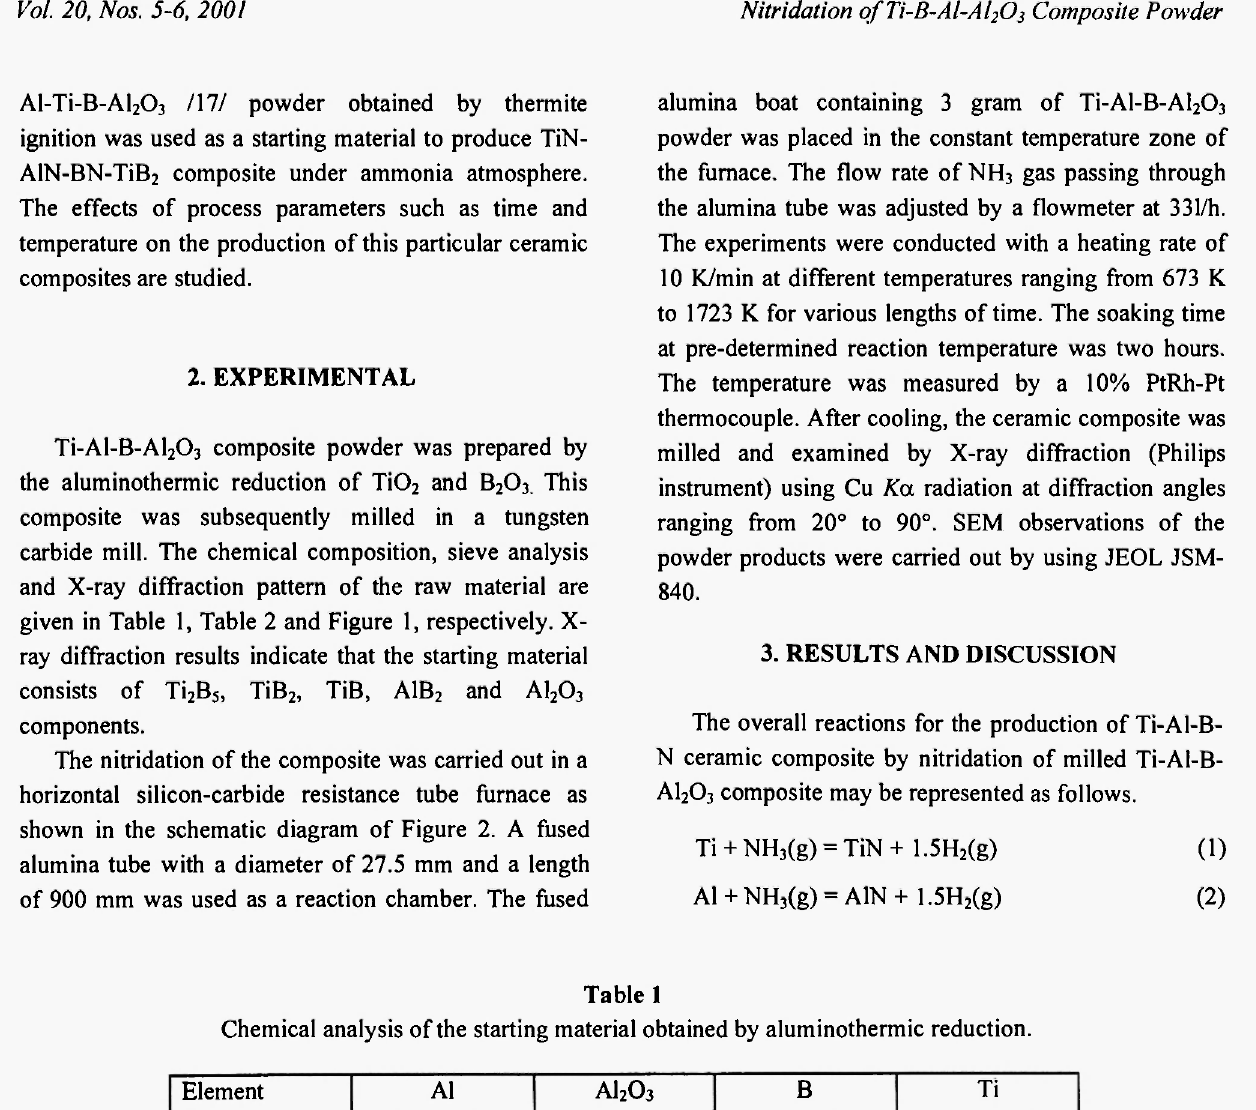
Chemical analysis of the starting material obtained by aluminothermic reduction. Element